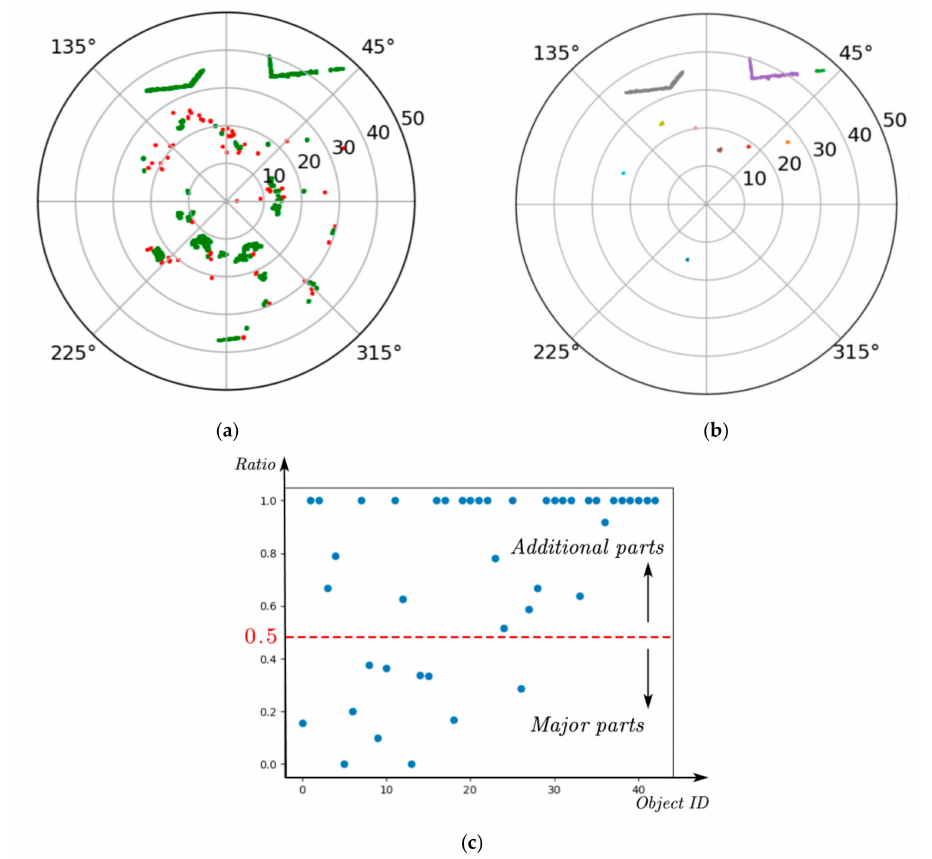
Figure 7. Extracting major parts in the non-key region. ( a ) Using density-based spatial clustering of applications with noise (DBSCAN) to exclude sparser points, where green scatters are denser points and red scatters are sparser points. ( b ) 2D display of major parts in the non-key region. ( c ) The ratio of slices formed by two points in denser objects clustered by